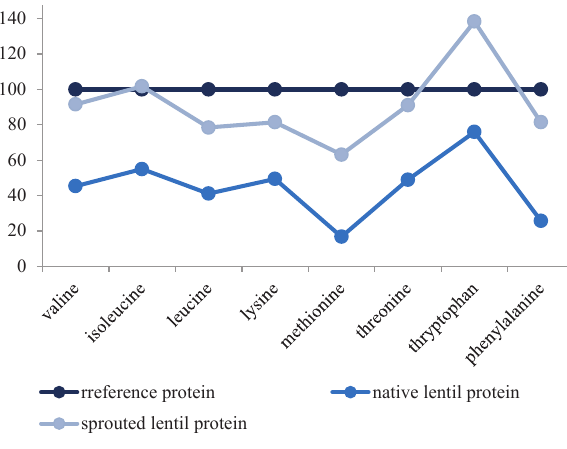
Figure 2 Effect of germination on lentil amino acid score